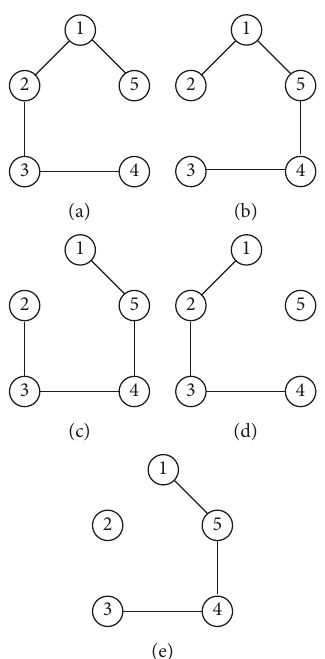
, p 1 , 2 , 3 , 4 , 5. (a) G 1 , (b) G 2 , p (cid:31)